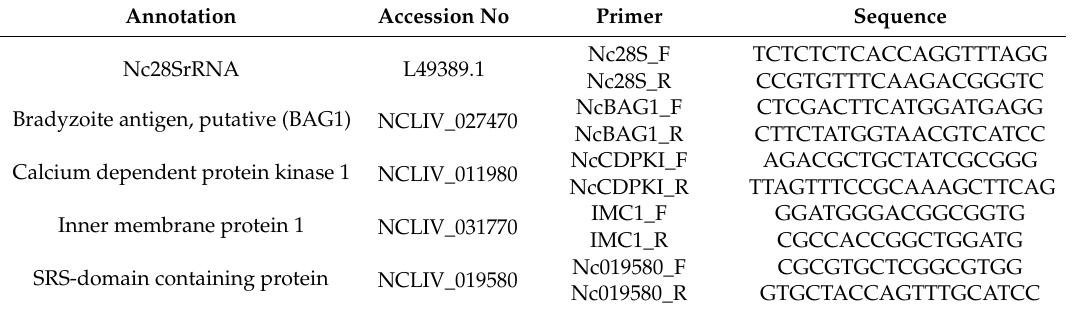
Table 1. List of primers used in this